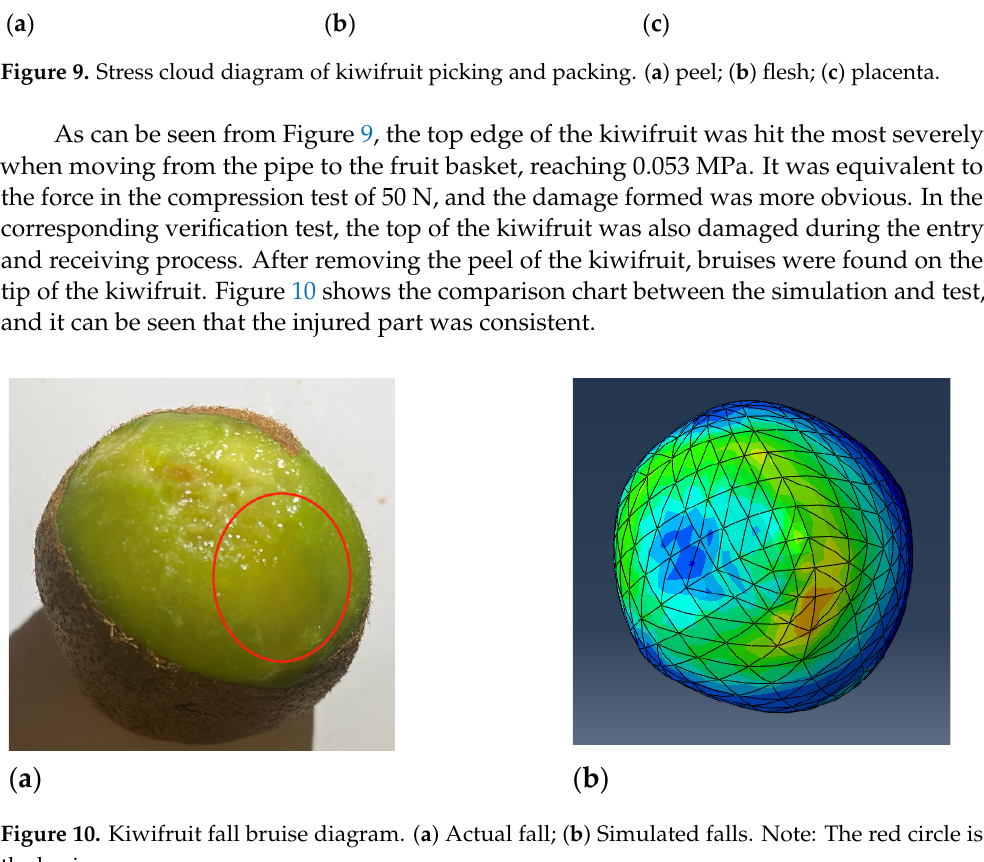
After the kiwifruit picking test, the kiwifruit in the fruit basket was removed and allowed to stand before near − infrared spectroscopy 24 h later. It can be seen from Figure 10 that the difference between the top of the kiwifruit and the impact point and the non − impact point of the fruit basket was obvious, so there was certain damage to the top of the kiwifruit fruit.